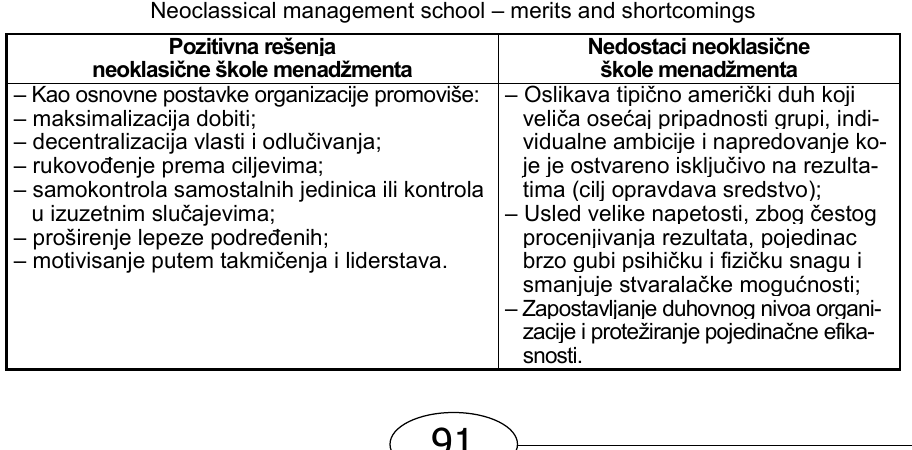
Nedostaci neoklasi č ne škole